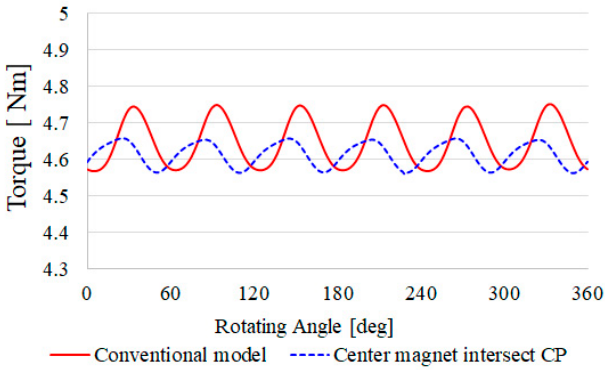
Figure 12. Torque waveform comparison of the existing and final models.